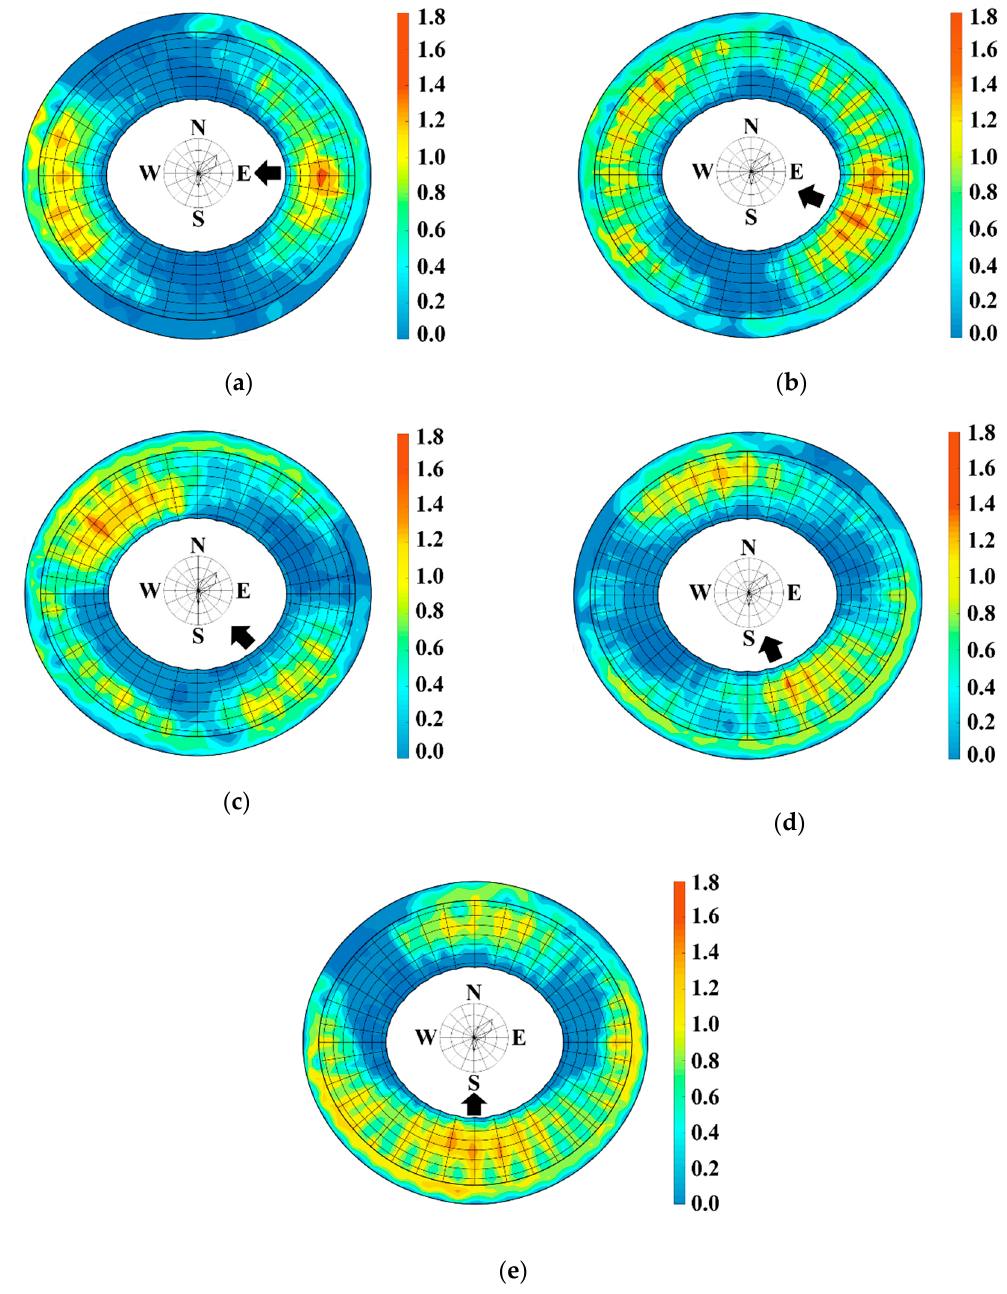
Figure 15. Generated snow distribution shape coefficient μ : ( a ) 0°; ( b ) 22.5°; ( c ) 45°; ( d ) 67.5°; and ( e ) 90°.